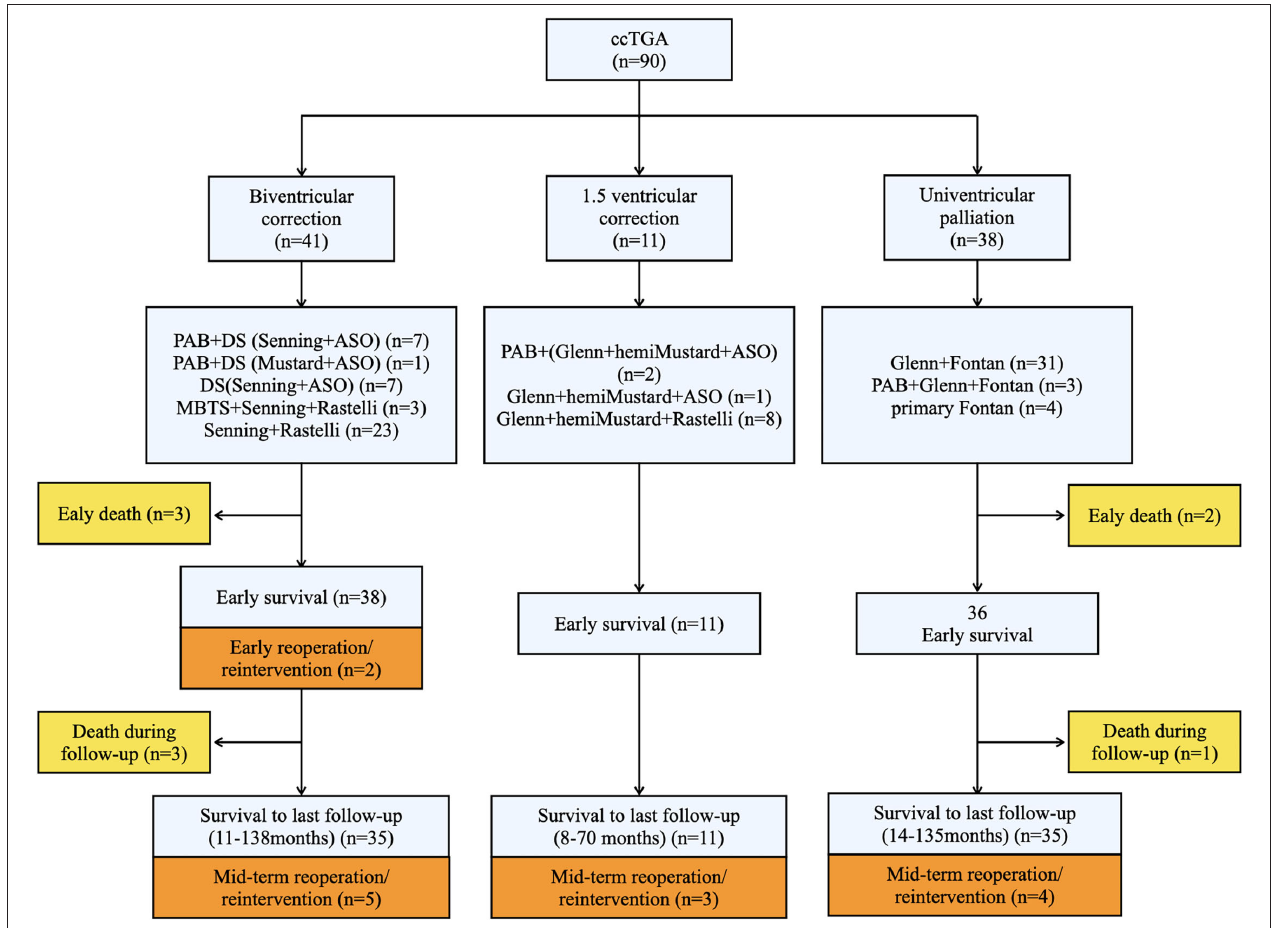
FIGURE 1 | Schematic research route providing the overall illustration of our study. Three surgical strategies were adopted and the specific techniques were provided. Death and reoperation cases were shown in yellow and orange squares, respectively. The numbers of patients were indicatied in brackets of each squares. ccTGA, congenitally corrected transposition of the great arteries; PAB, Pulmonary artery band; DS, double switch; ASO, arterial switch operation; MBTS, modified Blalock-Taussig